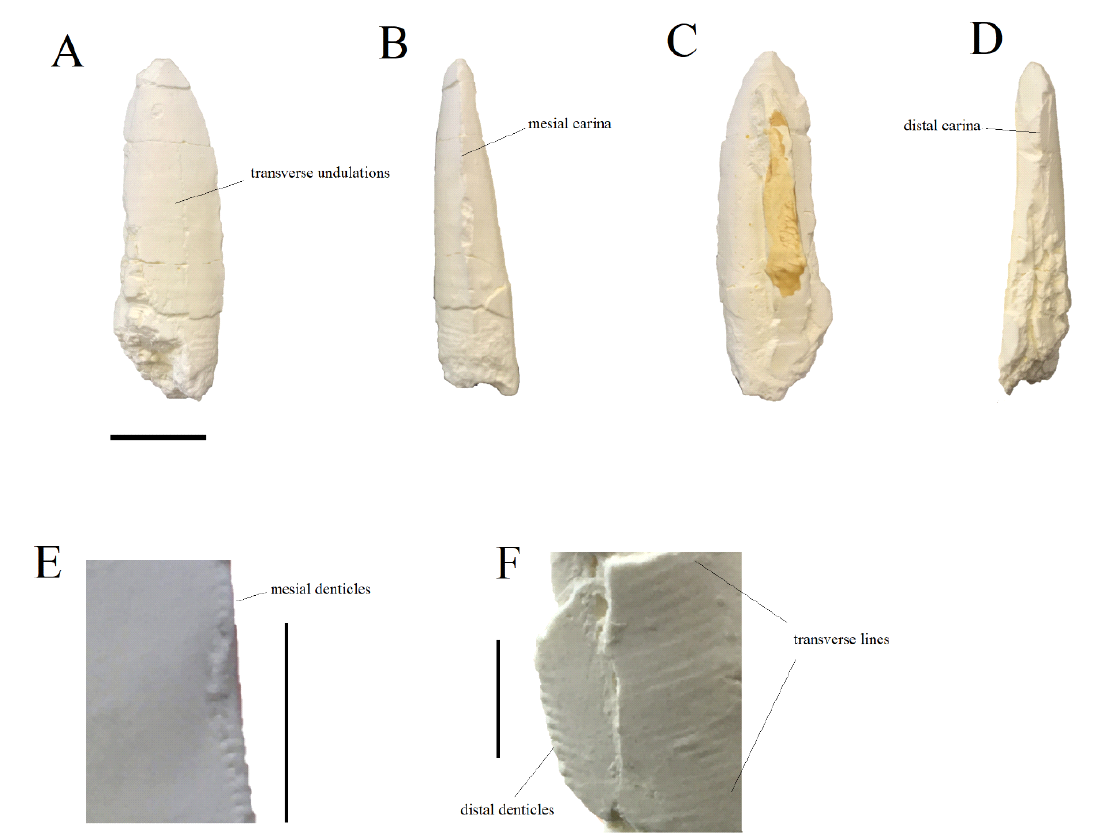
Fig. 2. Cast of KS 7001 in lingual (A), mesial (B), labial (C), distal (D) views, and magnified mesial (E) and distal (E) carinae. Scale bar = 20 mm (A-D), =5 mm